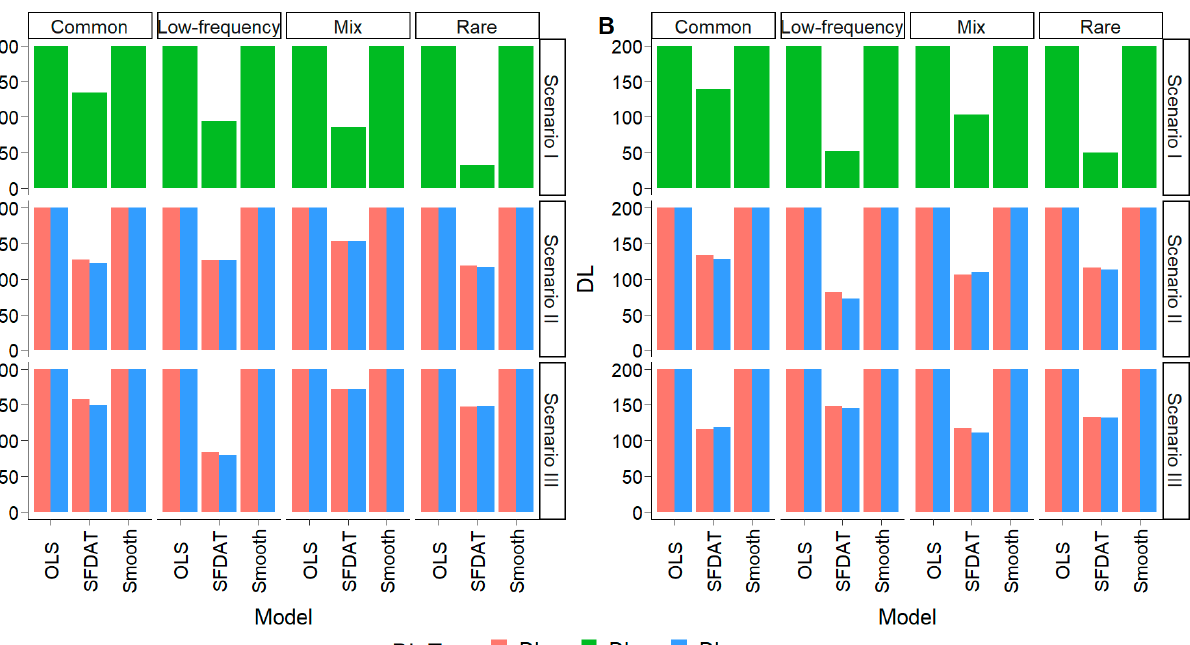
Figure 2. The simulation CSR of four variants using OLS, SFDAT and Smooth under three scenarios of Case I. ( A ): The situation of linkage equilibrium; ( B ): the situation of linkage disequilibrium; Sce- nario I: Set a positive causal SNP at locus 450 in the gene region. Scenario II: Set a positive causal SNP at locus 100 and 800 in the gene region, respectively. Scenario III: Set a positive causal SNP and a negative causal SNP at locus 100 and 800 in the gene region, respectively.